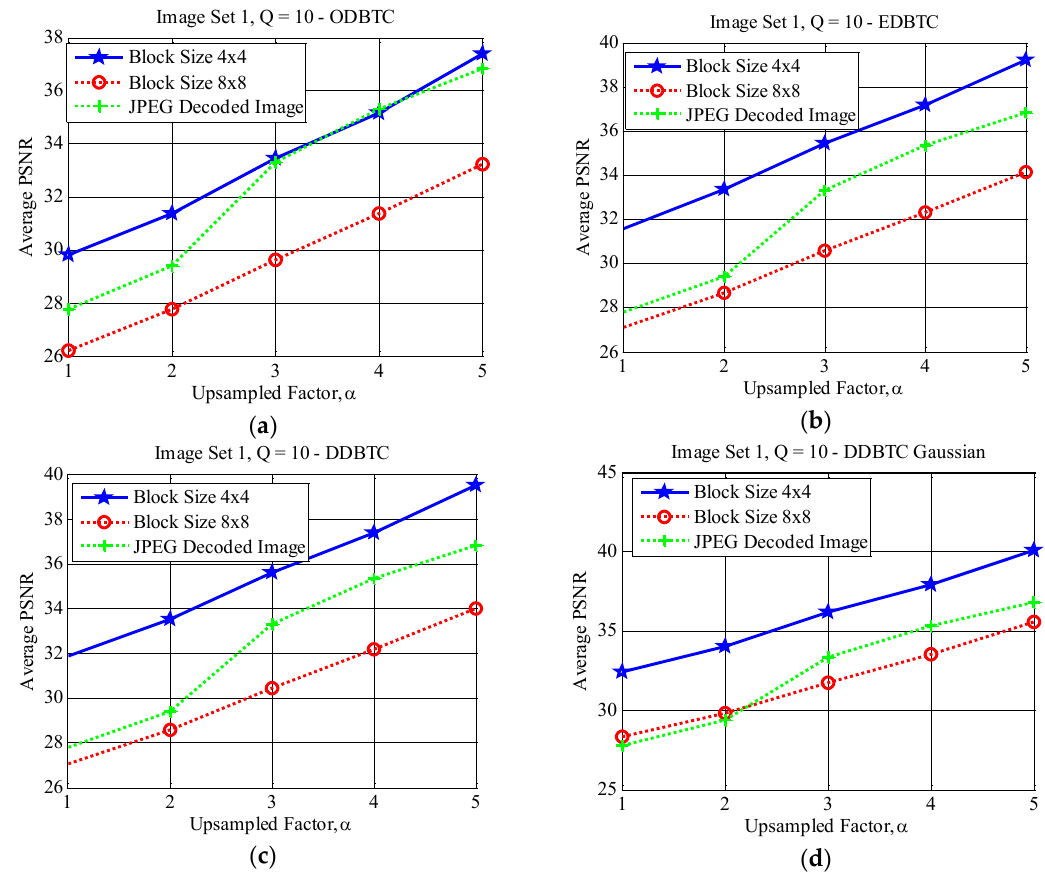
Figure 19. Effect of image block sizes on Image Set 1 with 𝑄 = 10 over ( a ) ODBTC; ( b ) EDBTC; ( c ) DDBTC; and ( d ) DDBTC Gaussian scheme.